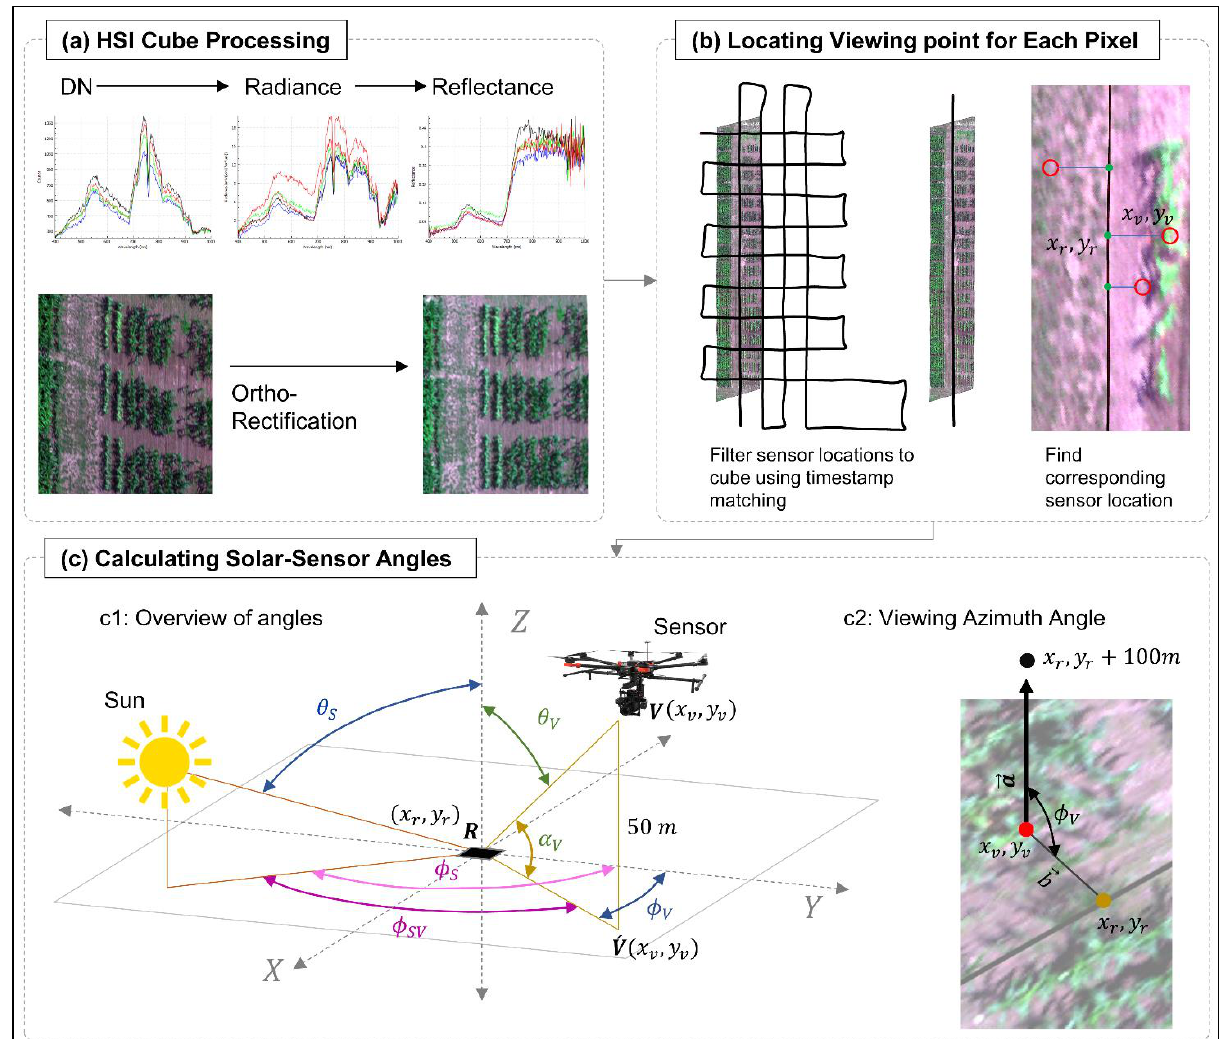
Figure 2. Overview of methods for the extraction of solar-sensor zenith and azimuth angles, i.e., (a) hyperspectral cube processing involves converting digital number (DN) to radiance, reflectance, and ortho-rectified images, (b) locating corresponding sensor location for each pixel in a hyperspectral cube, and (c) calculating three solar-sensor zenith and azimuth